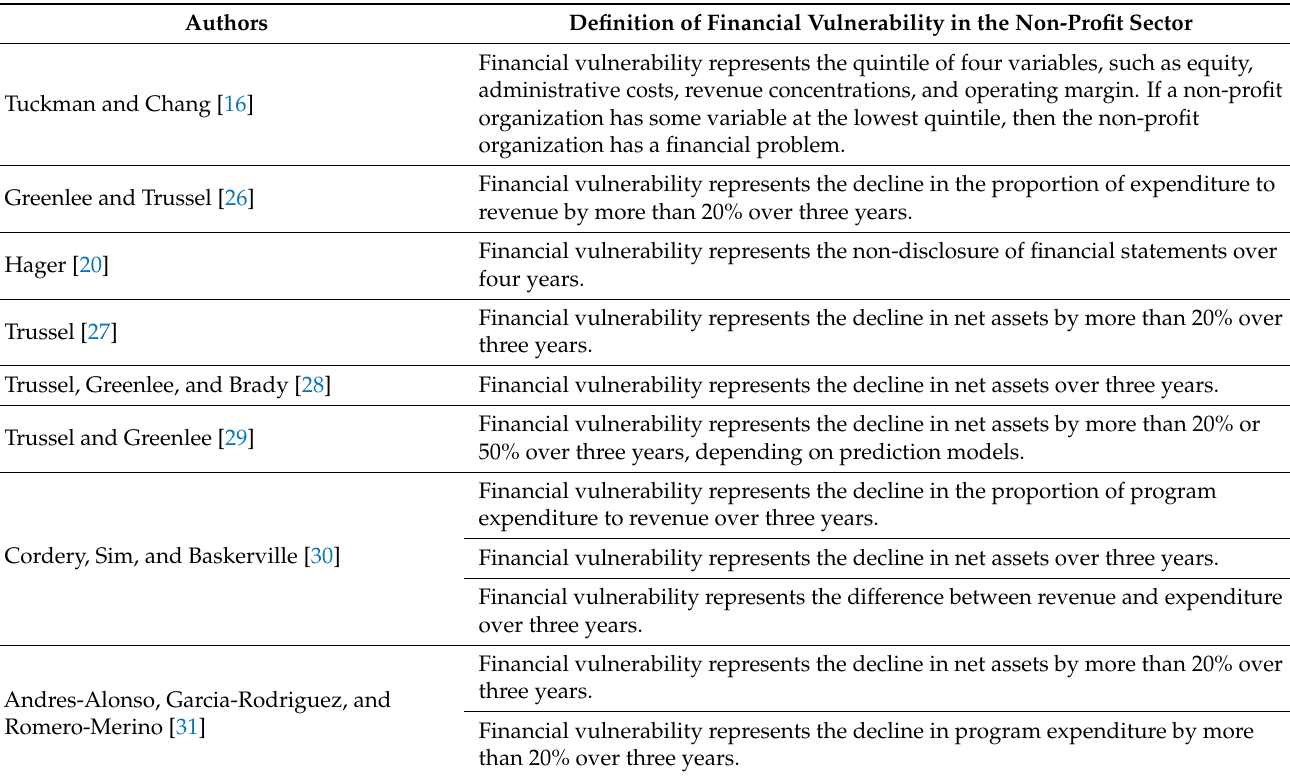
Table 1. Definitions of financial vulnerability according to renowned